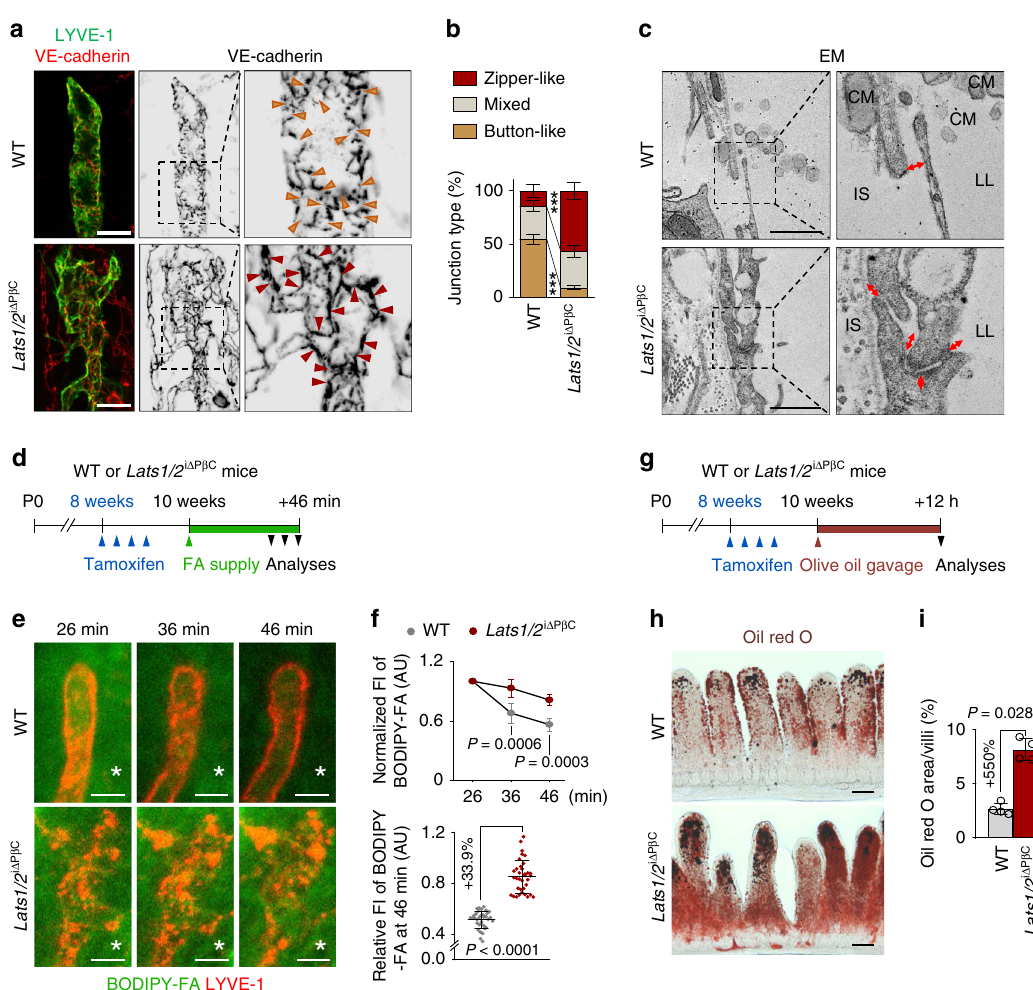
Fig. 2 Button-to-zipper junctional transition and impaired lipid absorption in Lats1 /2 i Δ P β C mice. a , b Representative images and comparison of VE- cadherin + lymphatic endothelial cell (LEC) junctions of LYVE-1 + lacteals in WT and Lats1/2 i Δ P β C mice. Black dotted box is magni fi ed in the right panel and arrowheads indicate the lacteal junctional pattern that is dominant in each group with the same color described in b . Horizontal bars of each colored segment represent mean ± SD of 5 – 10 villi/mouse and n = 5 mice/group pooled from three independent experiments. *** P < 0.0001 versus WT by two- way ANOVA with Holm – Sidak ’ s multiple comparisons test. Scale bars, 20 μ m. c Representative transmission electron micrographs (EM) of a lacteal in WT and Lats1/2 i Δ P β C mice. Black dotted box is magni fi ed in the right panel. LL, lacteal lumen; CM, chylomicron; IS, interstitium of lamina propria. Similar fi ndings were observed in n = 5 mice/group from two independent experiments. Scale bars, 1 μ m. d Diagram depicting the schedule of intravital imaging of lipid clearance from lamina propria via lacteals after supplying the BODIPY-fatty acid (FA) into the WT or Lats1/2 i Δ P β C mice and their analyses until after 46 min. e , f Representative intravital images and comparisons of the drainage of BODIPY-FA from the lamina propria (white asterisks) through the LYVE-1 + lacteal in WT and Lats1/2 i Δ P β C mice. Each dot indicates a value of 4 – 8 villi/mouse and n = 7 (WT) or n = 8 ( Lats1/2 i Δ P β C ) mice pooled from four independent experiments. Horizontal bars indicate mean ± SD and P value versus WT by two-tailed Mann – Whitney U test. FI, fl uorescence intensity; AU, arbitrary unit. Scale bars, 20 μ m. g Diagram depicting the schedule of olive oil gavage at 12 h prior to the intestinal sampling in WT or Lats1/2 i Δ P β C mice. h , i Representative images and comparison of Oil red O staining in intestinal villi of WT and Lats1/2 i Δ P β C mice. Each dot indicates a mean value of 5 – 7 villi/mouse and n = 4 mice/group pooled from two independent experiments. Horizontal bars indicate mean ± SD and P value versus WT by two-tailed Mann – Whitney U test. Scale bars, 100 μ